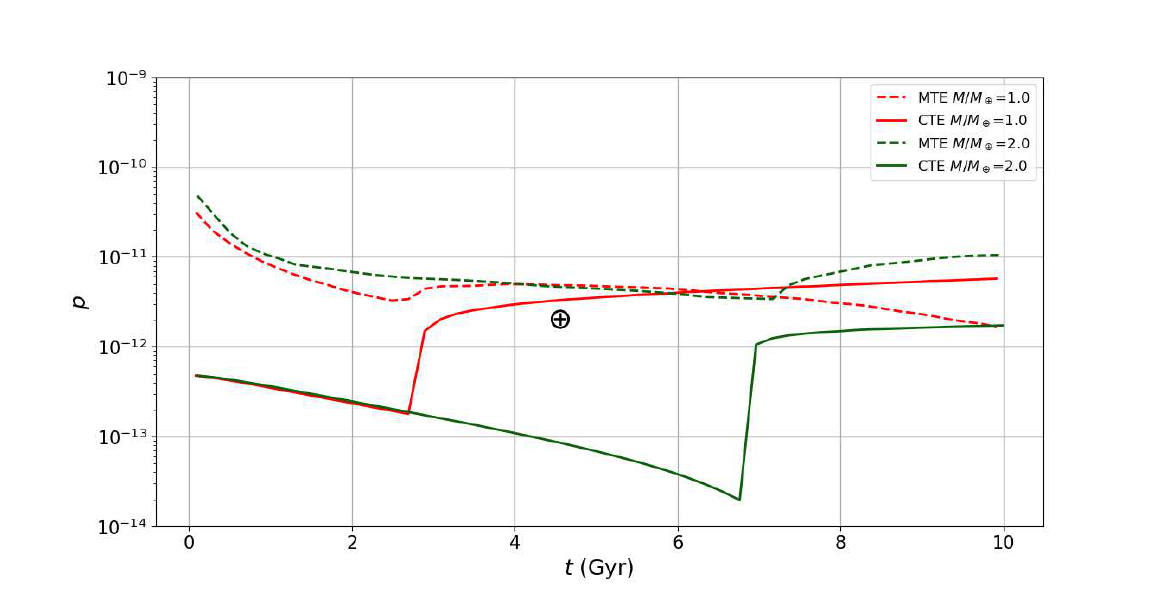
Figure 11. Evolution of the convective power density p in CTE (solid lines) and MTE (dashed lines) for two different planetary masses 1.0 and 2.0 M . p is one order of magnitude larger in MTE and falls faster than in the CTE model due to differences in the estimations of the ⊕ convective power